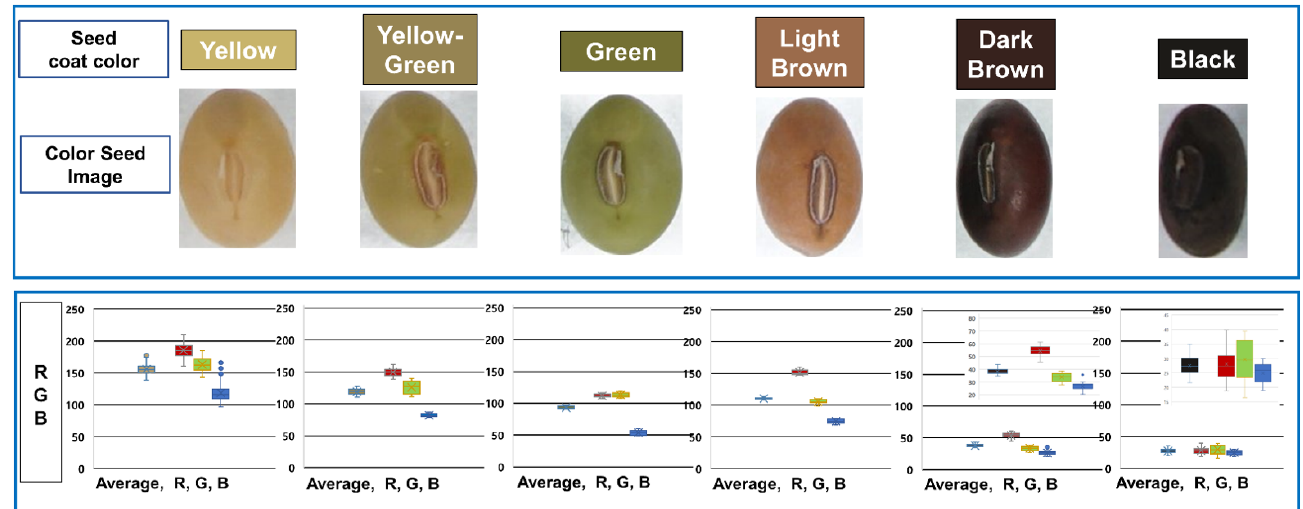
Figure 6. Classification of soybean seed color according to the UPOV guideline. On the top, the seed coat color was assigned based on six colors: yellow (IT134357), yellow-green (IT162934), green (IT215881), light brown (IT262893), dark brown (IT165456), and black (IT2082671). The box plot shows the R (red), G (green), and B (blue) values of the germplasm classified by the seed coat color and their average. The boxes in each figure are in the order of average, R, G, and B.